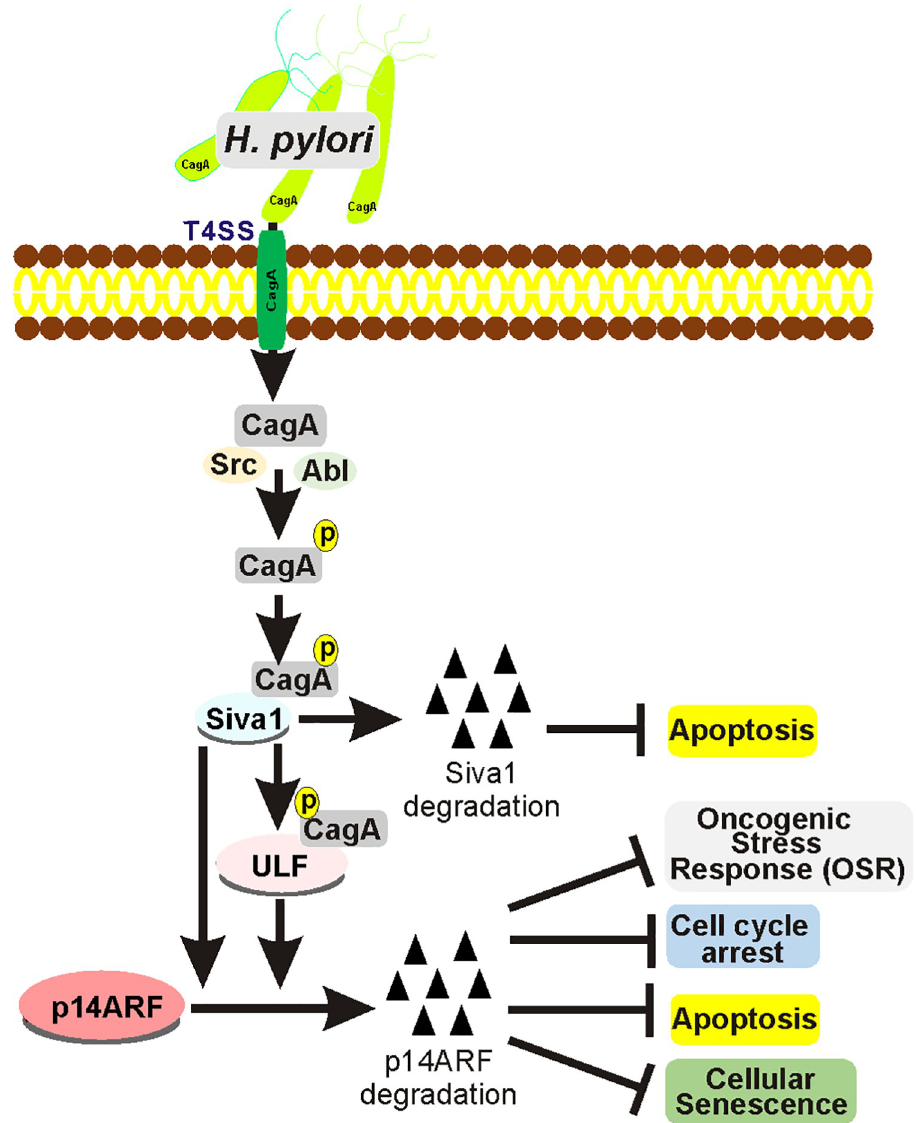
Fig 9. Scheme depicting the regulation of ULF, SIVA1 and p14ARF proteins during H . pylori